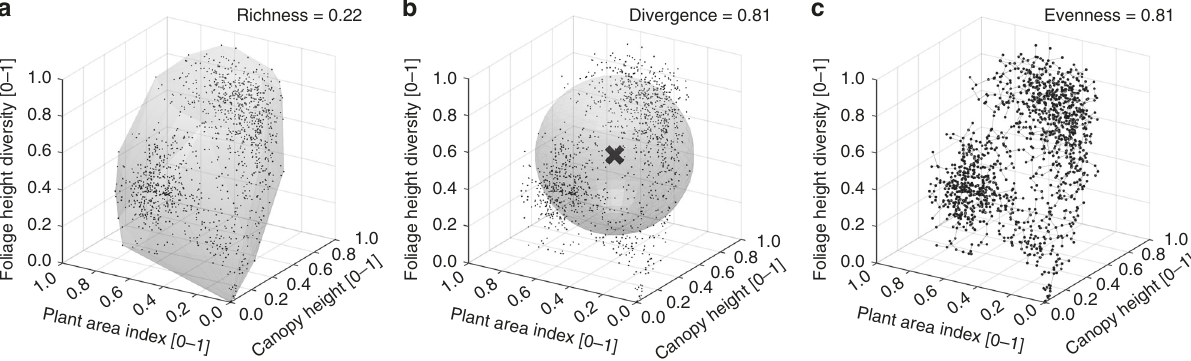
Fig. 2 Three aspects of functional diversity based on morphological forest traits of a circular area with a radius of 120 m. The three traits are foliage height diversity, plant area index and canopy height in relative units from 0 to 1. a The shaded volume is functional richness, b the distance from the surface of the shaded sphere is functional divergence and c the variation of segment length in the minimum spanning tree is